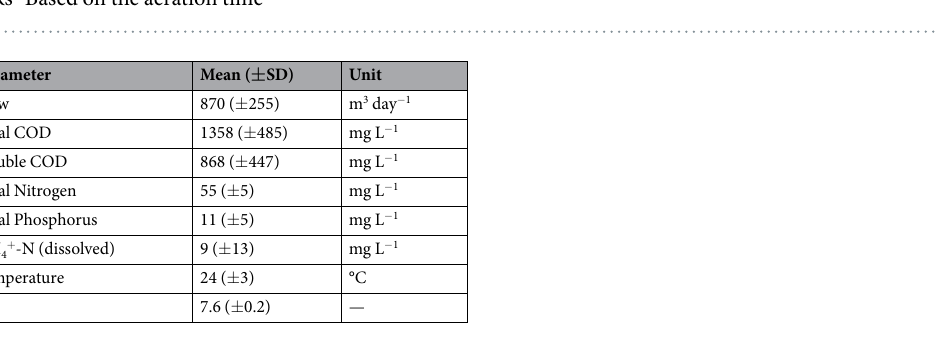
Table 2. Comparison of the main characteristics of the plant before (I) and after the densification strategy (III). a Based on residual COD after the dissolved air flotation unit (kg day − 1 ) over the total biomass present in both SBRs b Based on the aeration time